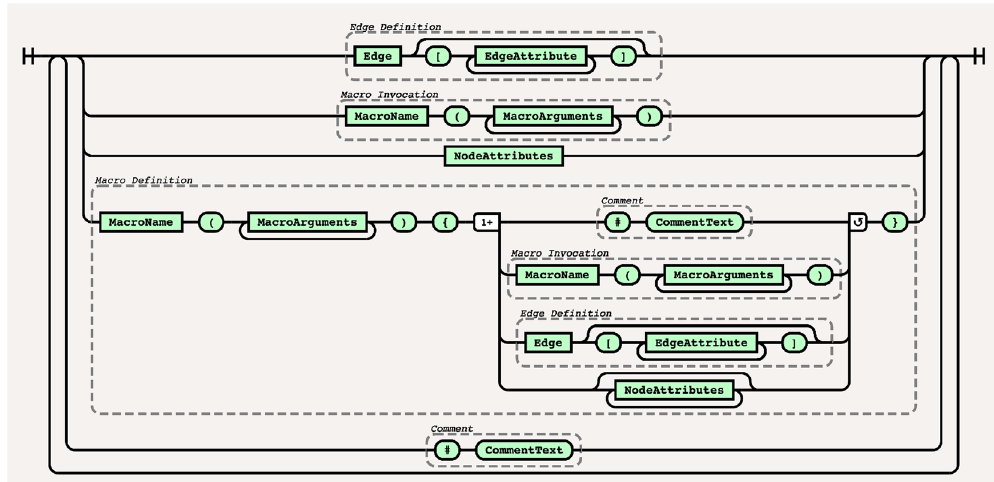
Figure 8. The DotMotif Syntax in railroad-diagram form. The DotMotif DSL is a whitespace-agnostic language with hash-symbol comments and curly-brace bracketed macros. Edges are defined with -> -arrowlike syntax; edge attributes may be listed in JSON-like syntax. Node attributes may be listed in object dot-notation syntax. For example usage of this syntax system, refer to Architecture . This syntax is formally defined in